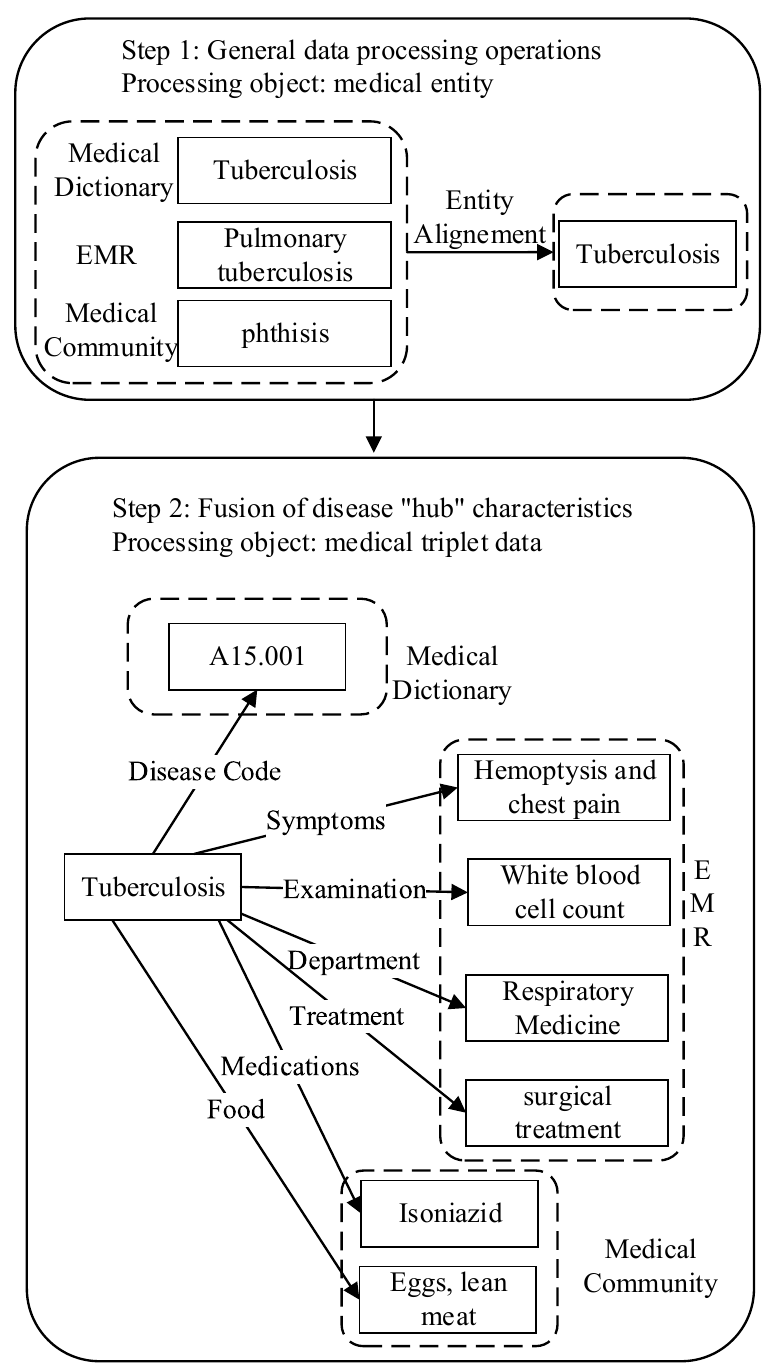
Figure 6. Two-Step Data Fusion Strategy.